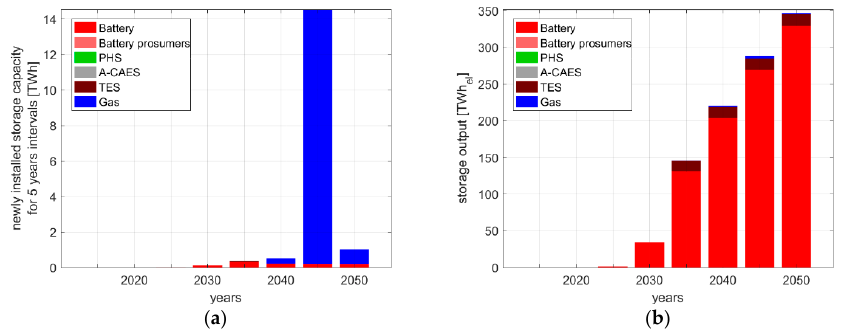
Figure 9. Additional storage capacity ( a ) and storage output ( b ) required from 2015 to 2050.